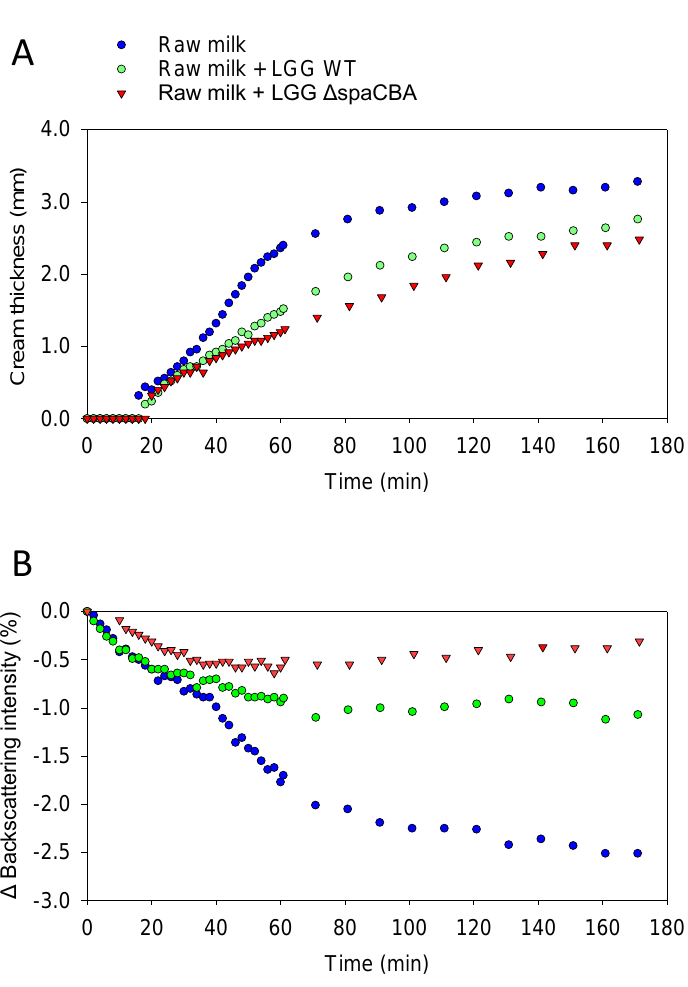
Figure 2. ( A ) Thickness of the cream layer obtained on the top of the sample as a function of time. ( B ) Backscattering intensity in the centre of the cylinder (35 mm) as a function of time. Raw milk (blue circle), raw milk-containing LGG WT (green circle) and raw milk-containing LGG ∆ spaCBA (red triangle). Table 1. Emulsion stability parameters obtained for raw milk without LGG, and in the presence of either LGG WT or LGG Δ spaCBA .